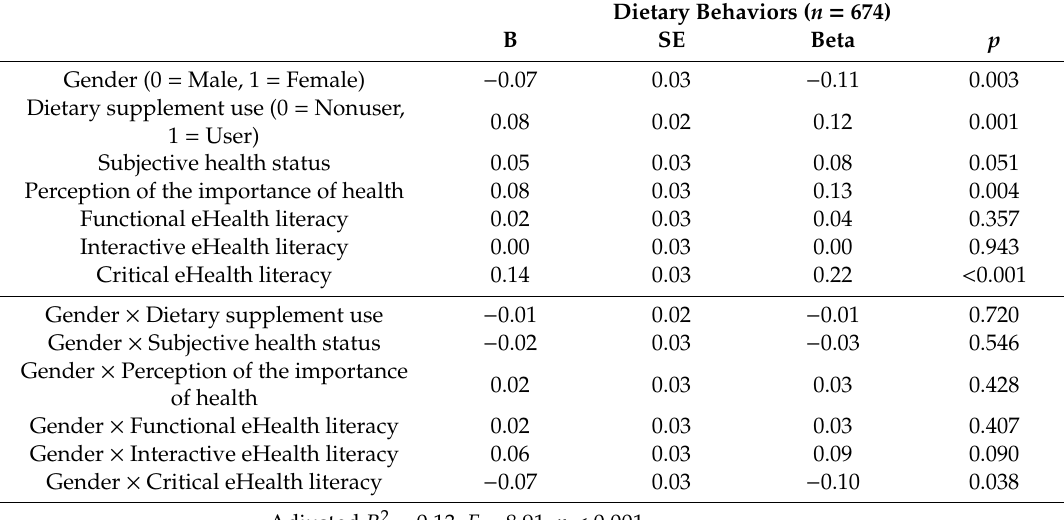
Table 2. Hierarchical regression analysis of dietary behaviors.